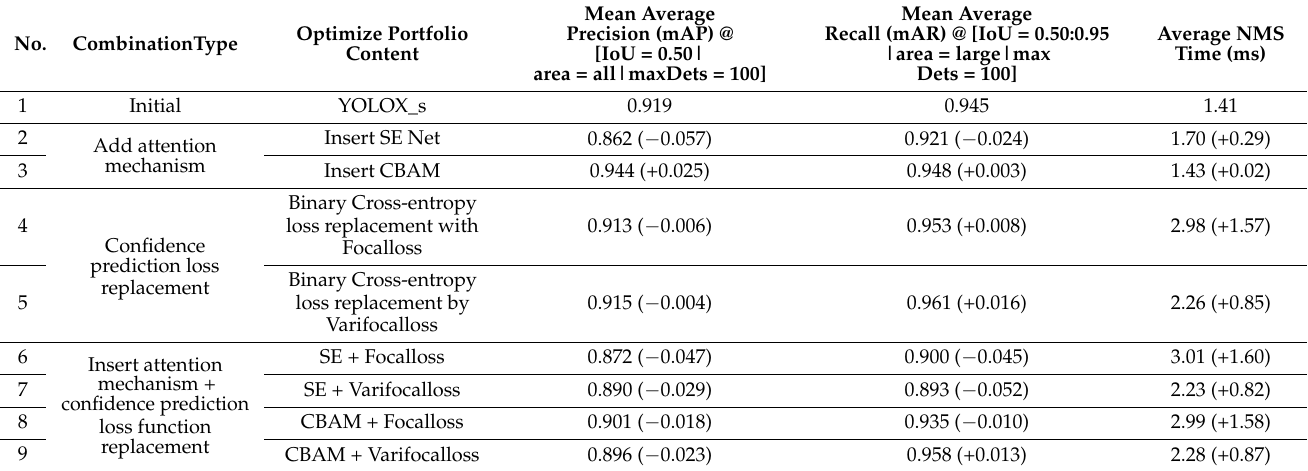
Table 2. Comparison of average precision, average recall and average NMS for 8 network optimiza- tion